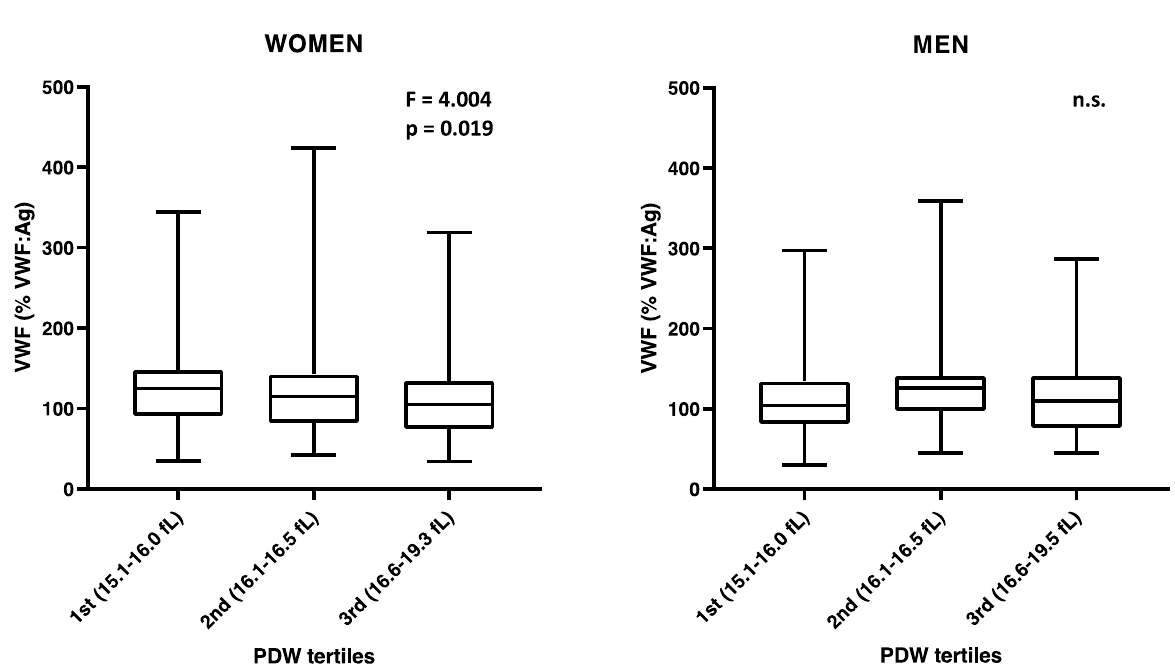
Figure 2. Sex-specific VWF levels by PDW tertiles. Distribution of VWF levels in women and men of the Moli-family cohort over PDW tertiles, as defined by the ranges indicated in parenthesis on the X axis. One-way ANOVA test significance is reported for each graph. N (WOMEN) = 402; N (MEN) = 325.